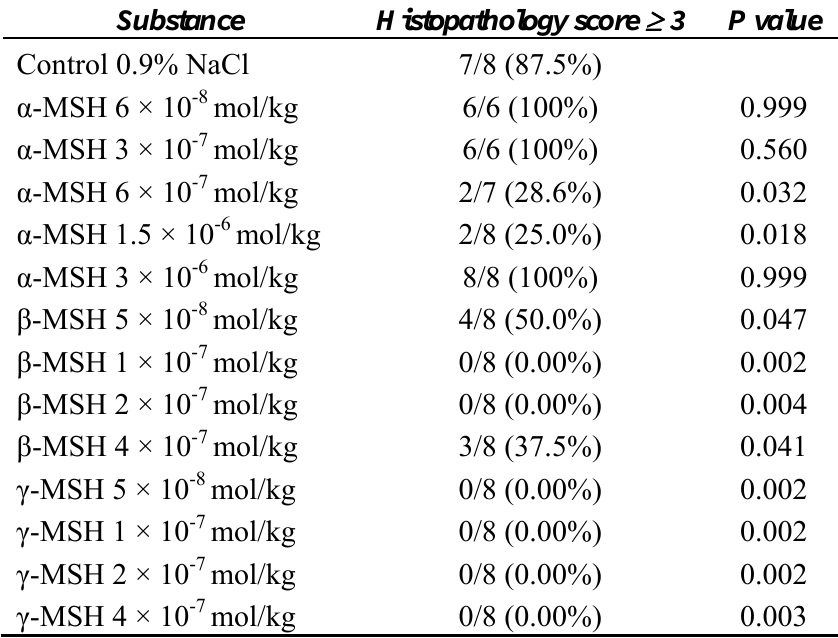
Table 5. Number and percentage of animals with histopathology score ≥ 3, 24 h after acetaminophen were given intraperitoneally 1 h before acetaminophen. P value is a result of comparison with the control group (Fisher exact probability